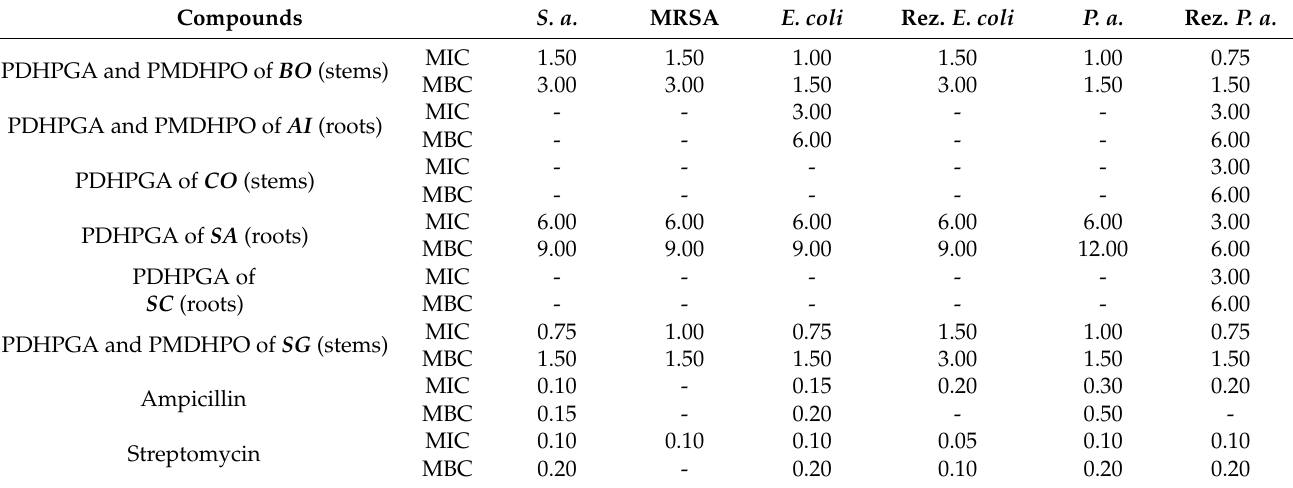
Table 2. In vitro antibacterial evaluation of PDHPGA and PMDHPO from stems and roots of BO , AI , CO , SA , SC , and SG